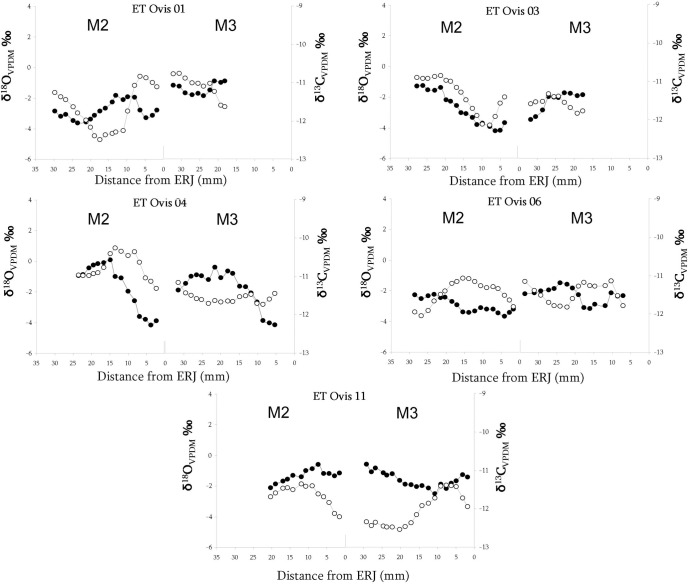
Sequential analysis of oxygen (δ18OV-PDB, white circles) and carbon (δ13CV-PDB, black circles) isotope composition in lower second (M2) and third (M3) molars in five of the sheep samples from Els Trocs cave.